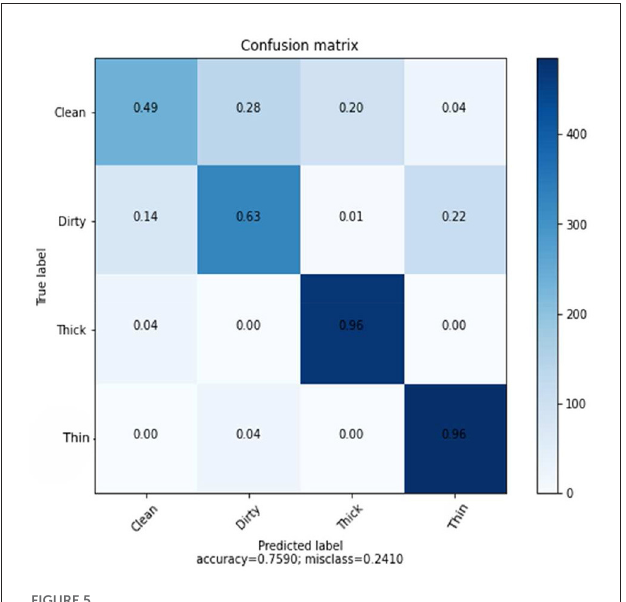
FIGURE5 Confusion matrix of SVM using CNN features.